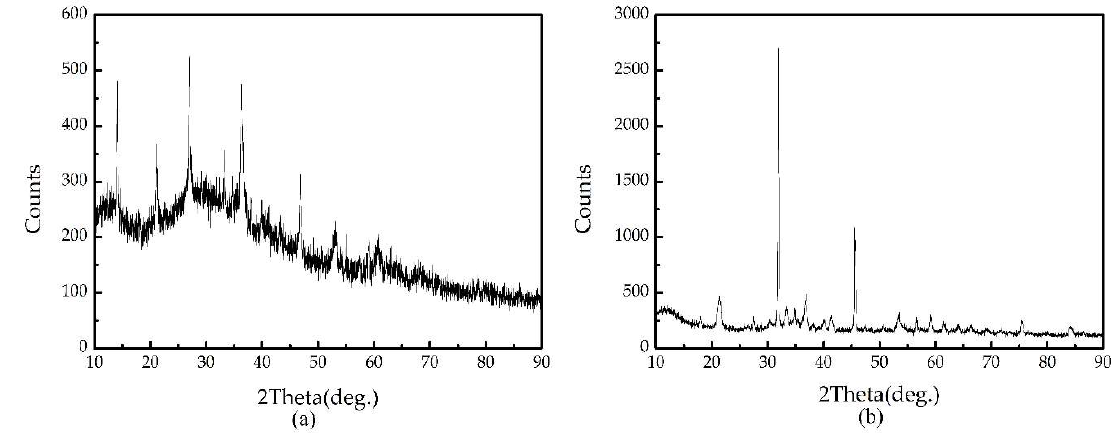
Figure 1. XRD patterns of ( a ) the actual pipe growth ring and ( b ) the prepared goethite.